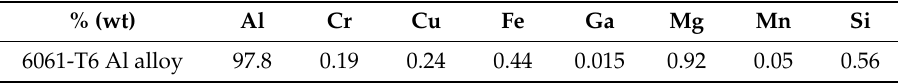
Table 2. Chemical composition of ultra low carbon steel.